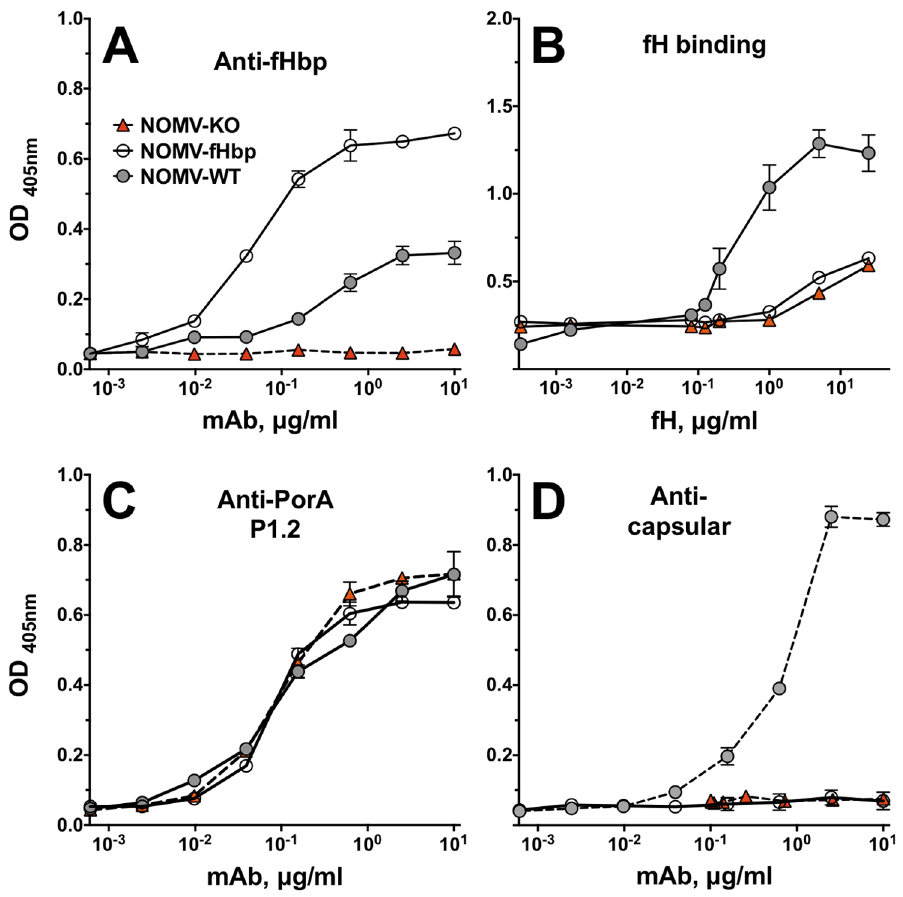
Figure 4. Characterization of NOMV vaccines by ELISA. Panel A. fHbp was measured using anti-fHbp mAb, JAR 5. Panel B. Binding of human fH to the NOMV vaccines was performed as previously described [43]. Panel C. PorA was measured using anti-PorA mAbs specific for P1.2 [92]. Panel D. MenW capsular polysaccharide was measured using anticapsular mAb, JW-W1.